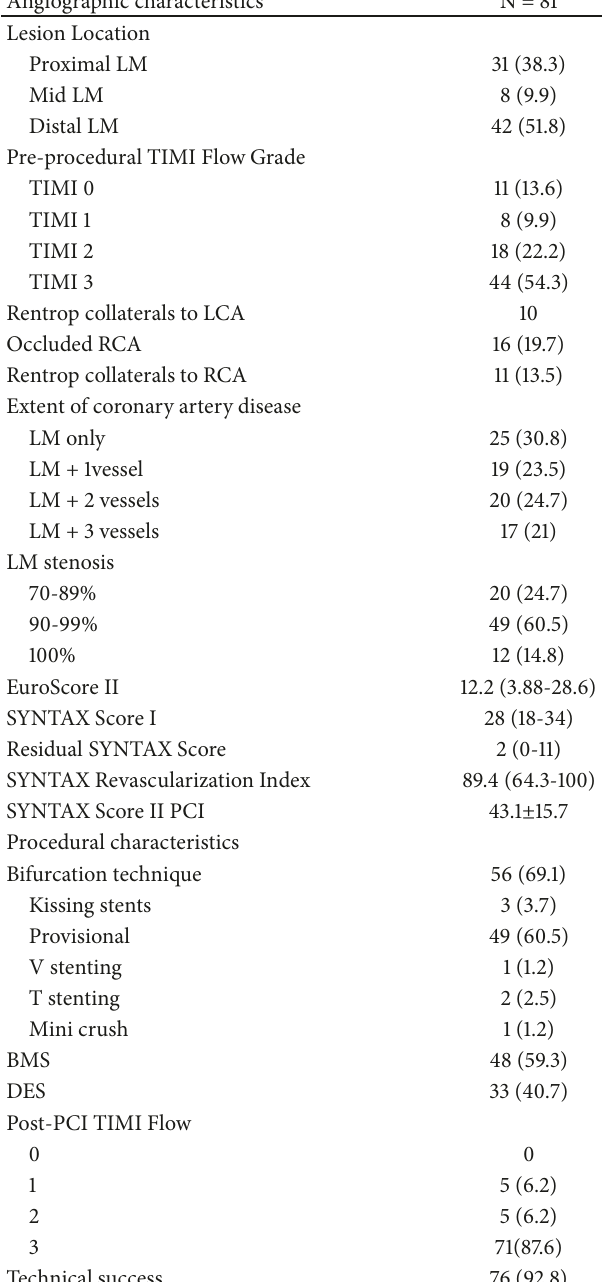
Table 2: Angiographic and procedural characteristics. Values are mean ± standard deviation, median (inter-quartile range), or number (%). BMS = Bare-Metal Stent, DES = Drug-Eluting Stent, LCA = left coronary artery, LM = Left Main, PCI = percutaneous coronary intervention, RCA = right coronary artery, and TIMI = Thrombolysis in Myocardial